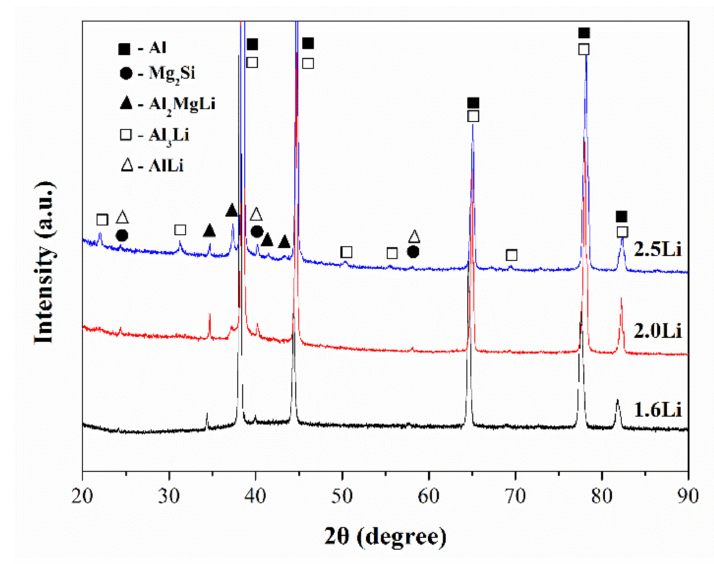
Figure 1. X-ray Di ff raction (XRD) results of as-cast Al-5.5Mg-xLi-0.1Zr